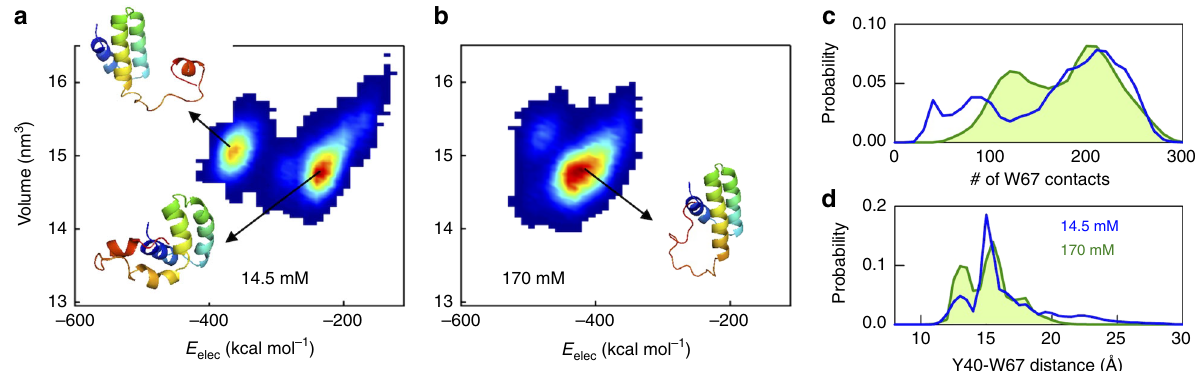
Fig. 4 Evidence for structural swelling from simulations. a, b Two-dimensional probability densitites derived from REMC simulations at 39 °C plotted in the spectral scale (blue to red represent low to high probabilities) at 14.5 mM ( a ) and 170 mM IS ( b ). The ordinate represents the protein volume and the abscissa is a measure of the electrostatic interaction energy that splits the native ensemble into two sub-ensembles at 14.5 mM IS. c , d Distribution of W67 contact probabilties ( c ) and Y40-W67 C α -C α distances ( d ). Source data are provided as a Source Data fi